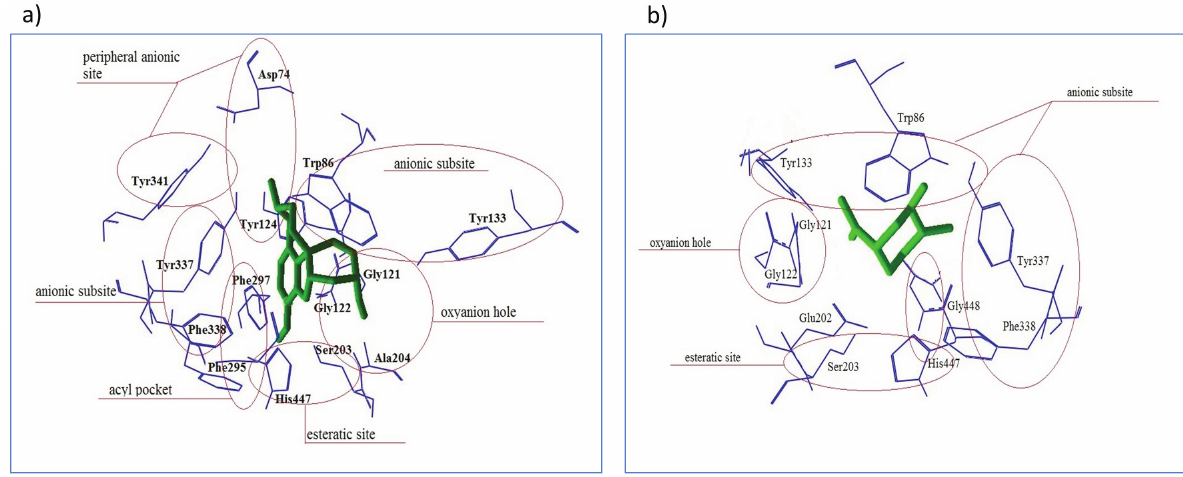
Figure 4: Comparison of amino acid residues (up to 4Å) for (a) galantamine and (b) carvone creating AChE active site. The image was created with the use of Yasara 11.2.15